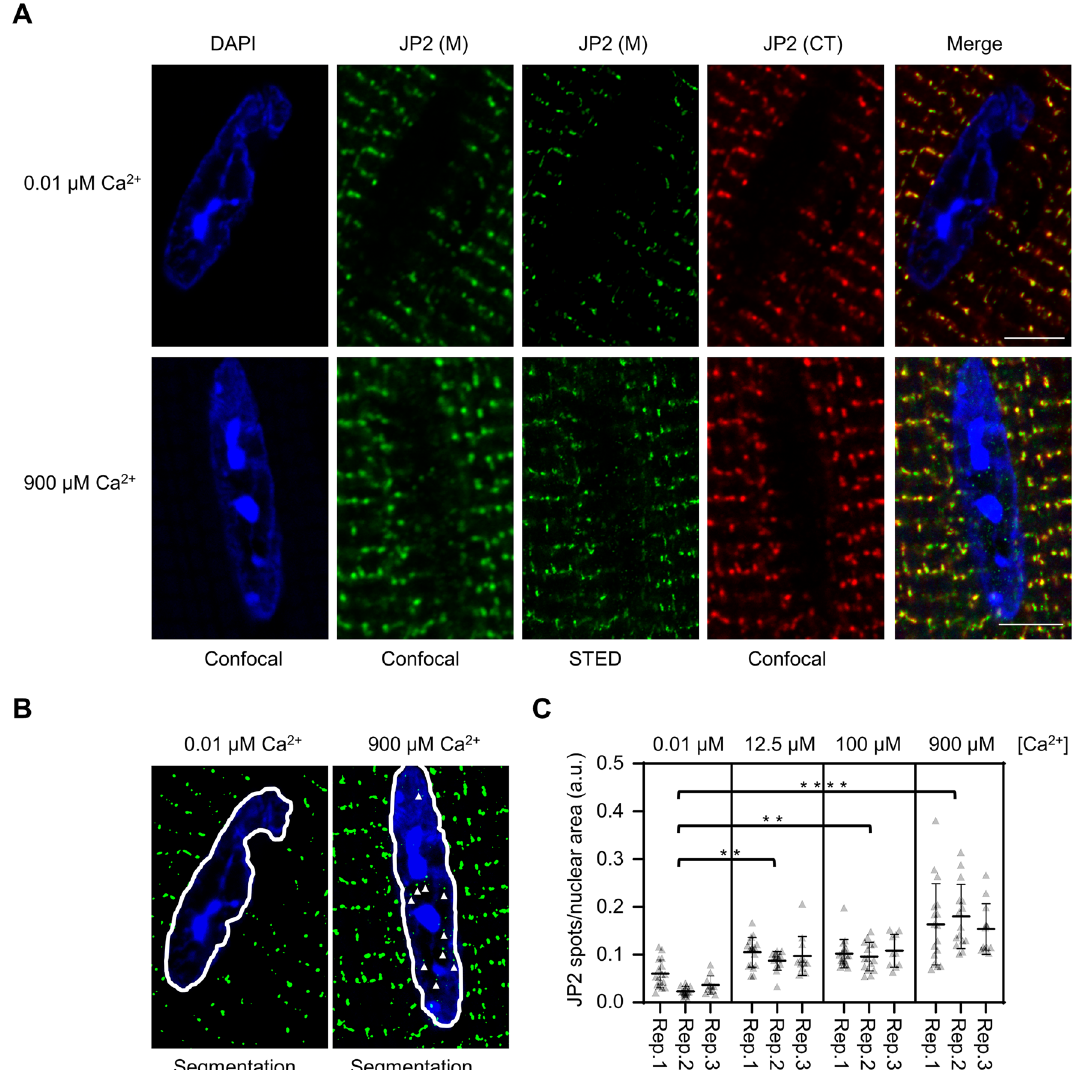
Figure 4. Micromolar extracellular Ca 2+ concentrations increase the number of intranuclear JP2 signal spots in living ionomycin-permeabilized mouse cardiomyocytes. ( A ) Confocal and STED images showing DAPI-stained intranuclear DNA-rich regions and JP2 co-immunofluorescence M and CT signals. Following the ionomycin (2 µM) induced exposure to a 900 µM high extracellular Ca 2+ concentration for 2 h, the antibody against the middle (M) JP2 portion robustly detected an increased number of small intranuclear JP2 signal spots, each visualized (green) by confocal and confirmed by STED imaging (compare 0.01 µM versus 900 µM). However, confocal imaging with the C-terminal JP2 antibody (CT) excluded any intranuclear signals (red). As expected, both the JP2 M and CT epitope-specific antibodies robustly detected the large cytosolic cluster signals with the typical striated pattern in cardiomyocytes (positive control). Scale bars, 5 μm. ( B ) Representative STED image segmentation examples for counting of the intranuclear number of JP2 signal spots labeled with the antibody against the M epitope (green). White triangles identify very small intranuclear JP2 signal spots in proximity but not colocalized with DNA-rich densely DAPI-labeled signal regions in central nuclear imaging planes suggesting not hetero- but euchromatic localization of intranuclear JP2. Apparently, the number of intranuclear JP2 signal spots is increased after exposure to the 900 µM extracellular Ca 2+ concentration. Same magnification as A . ( C ) Dot plot quantifiying intranuclear JP2 signal spots normalized to the intranuclear STED imaging area in living cardiomyocytes exposed to increasing extracellular Ca 2+ concentrations at 37 °C. Cultured ventricular cardiomyocytes were permeabilized with 2 µM ionomycin in culture for 2 h at 37 °C. Each Ca 2+ concentration was analyzed in triplicate based on 3 biological replicates and at least 15 cardiomyocytes per group (please refer to the methods section for details). Data are presented as mean ± SD. Differences between groups were assessed by nested one-way ANOVA. ** p < 0.01; **** p <